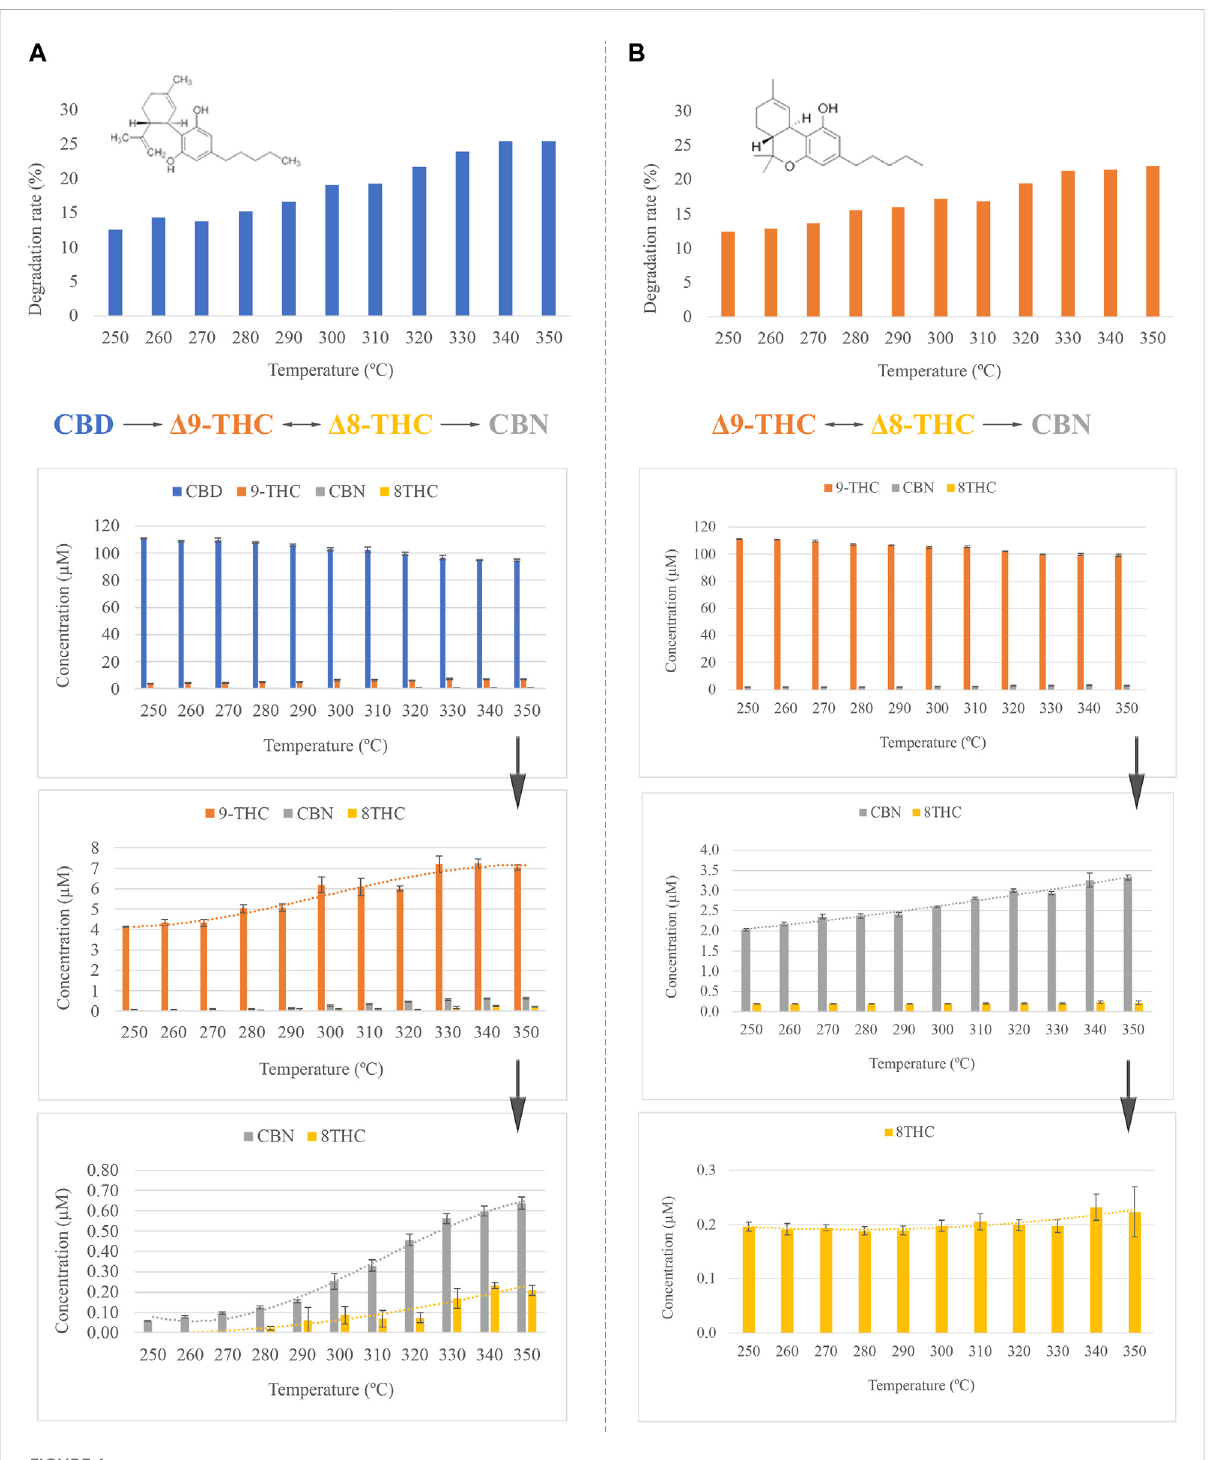
FIGURE 1 (A) Effect of the inlet temperature in CBD, degradation rate and concentration of CBD, Δ 9-THC, CBN, and Δ 8-THC expressed as µM. (B) Effect of the inlet temperature in Δ 9-THC, degradation rate and concentration of Δ 9-THC, CBN, and Δ 8-THC expressed as